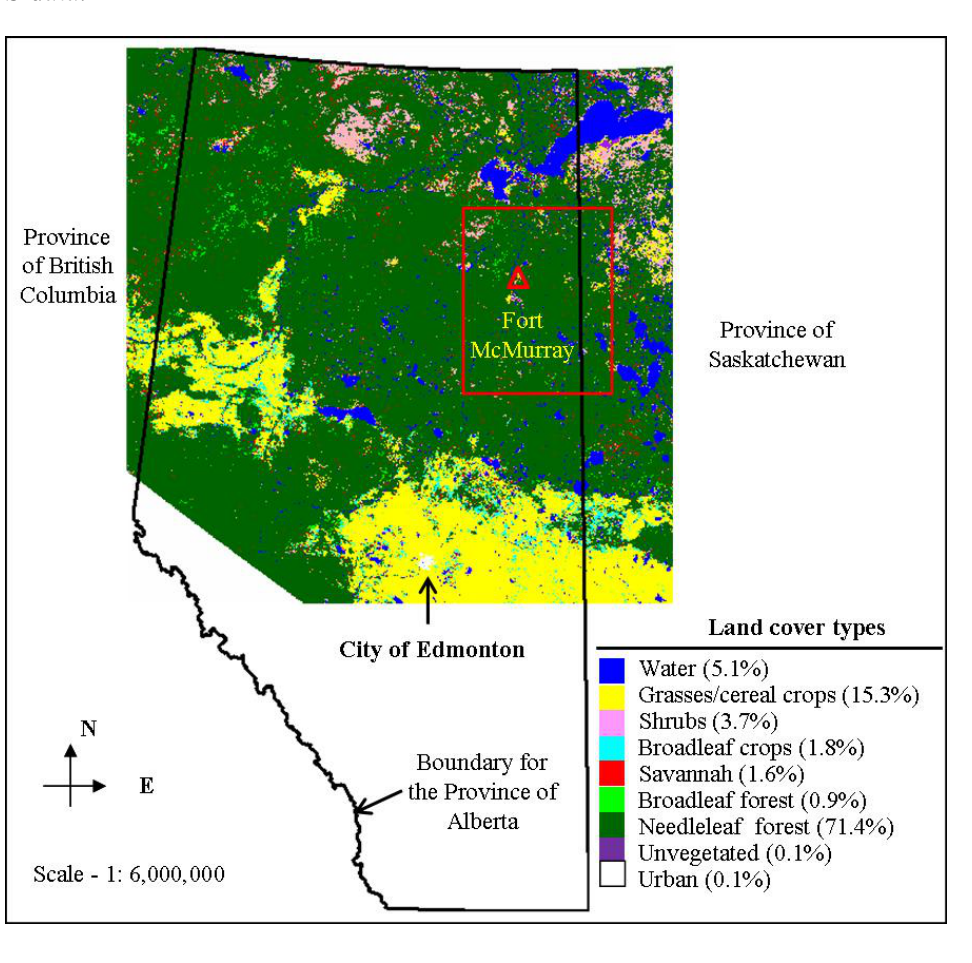
Figure 1. Extent of study area. A landcover map, derived from an annual composite of 2004 MODIS images, appears in the background. The black polygon outlines the Province of Alberta. The red box identifies the Athabasca Oil Sands Region, an area where field-based estimates of LAI were acquired to validate estimates of LAI generated from MODIS